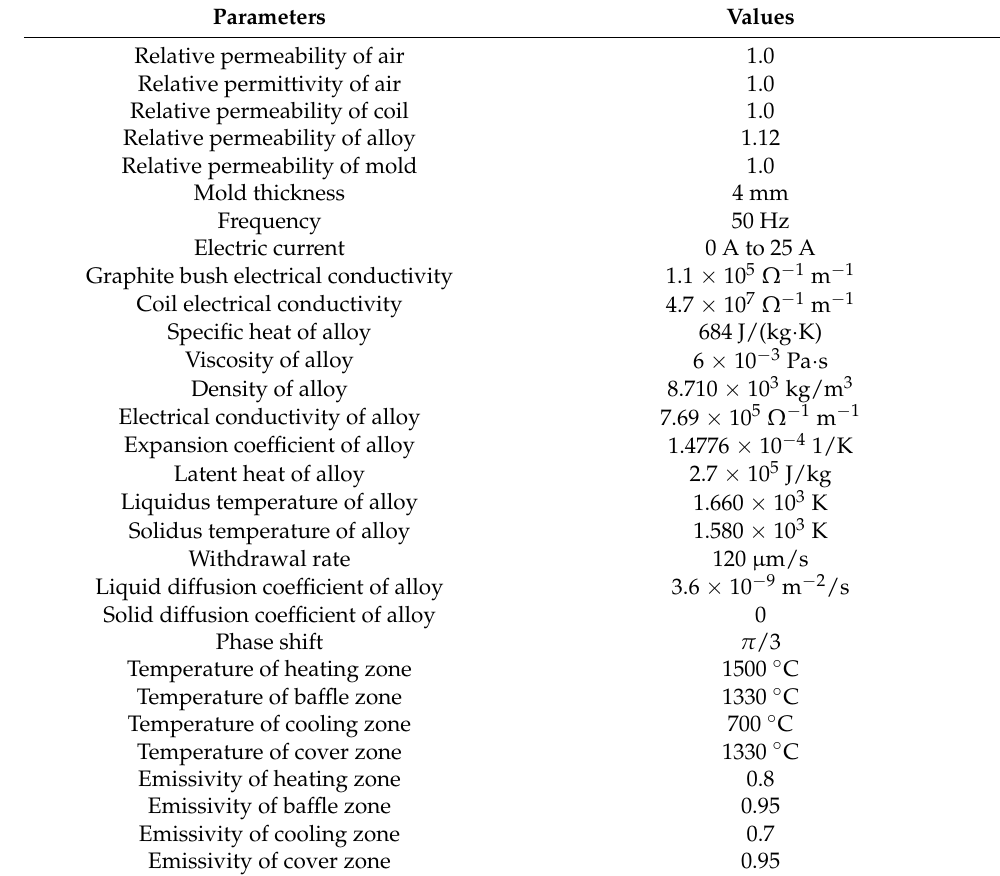
Table 2. Physical parameters of the FEM model.